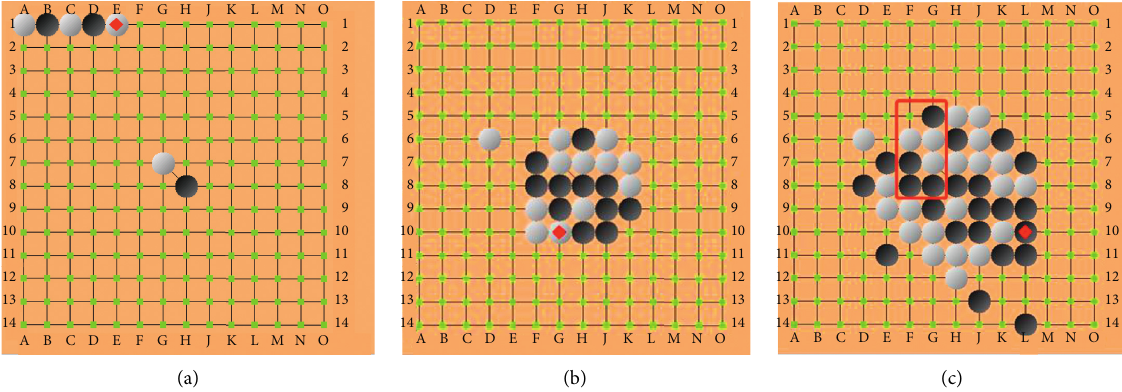
Figure 7: Comparison of learning efficiency with or without 2D normal distribution. (a) 2D normalization off. (b) 2D normalization on. (c) 2D normalization on and making a special board